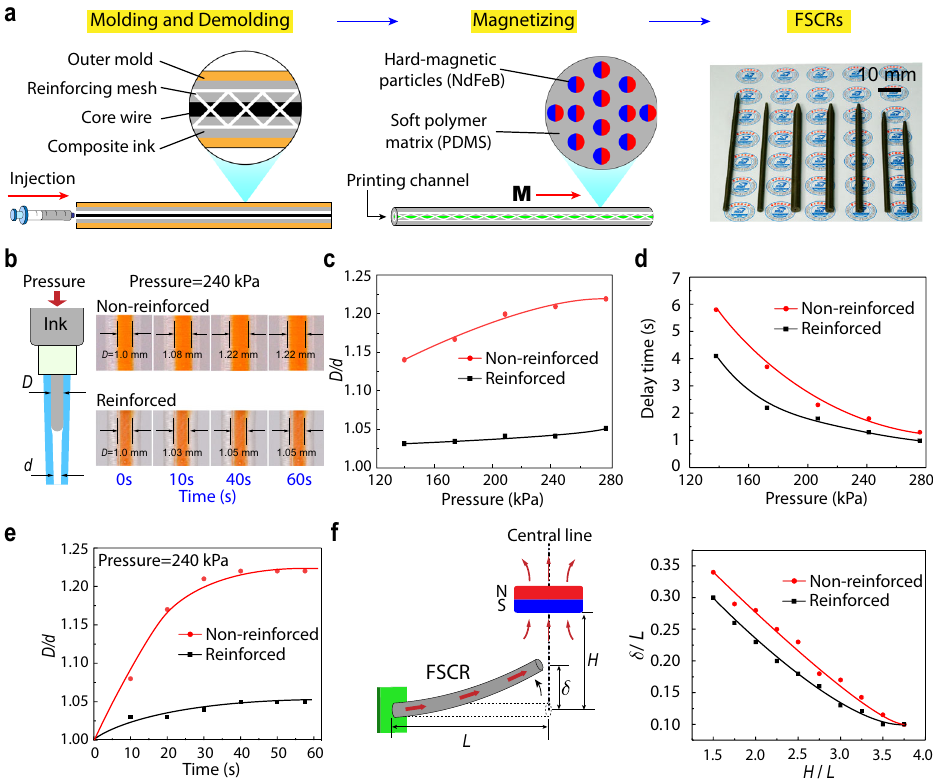
Fig. 2 Design of ferromagnetic soft catheter robot. a The fabrication process of PLA-reinforced FSCR using an injection molding method. The magnetic polarity of FSCRs denoted as M , is along its axial direction after being magnetized to saturation by a strong impulse magnetic fi eld. FSCRs with various diameters (4 – 7 mm) and lengths (80 – 110 mm) are shown on the right. b Sketch of printing ink (colored orange) extrusion process in an FSCR under applied pressure (left). L is the robot length. d and D are the diameter of the printing channel before and after ink extrusion, respectively. Experimental pictures of both reinforced and non-reinforced catheters ( L = 100 mm, d = 1 mm, catheter outer diameter 4 mm) under the pressure of 240 kPa (right). c Diameter expansion ratio D/d under various applied pressures for the reinforced and non-reinforced catheters. d Delay time as a function of applied pressure for the reinforced and non-reinforced catheters. e Plots of diameter expansion ratio D/d measured over times under the pressure of 240 kPa. f Schematic of FSCR bending under different magnetic fi elds generated by a single cubic permanent magnet (left). Experimental measurements of normalized de fl ection δ /L of non-reinforced and reinforced catheter plotted against the normalized actuating distance H/L